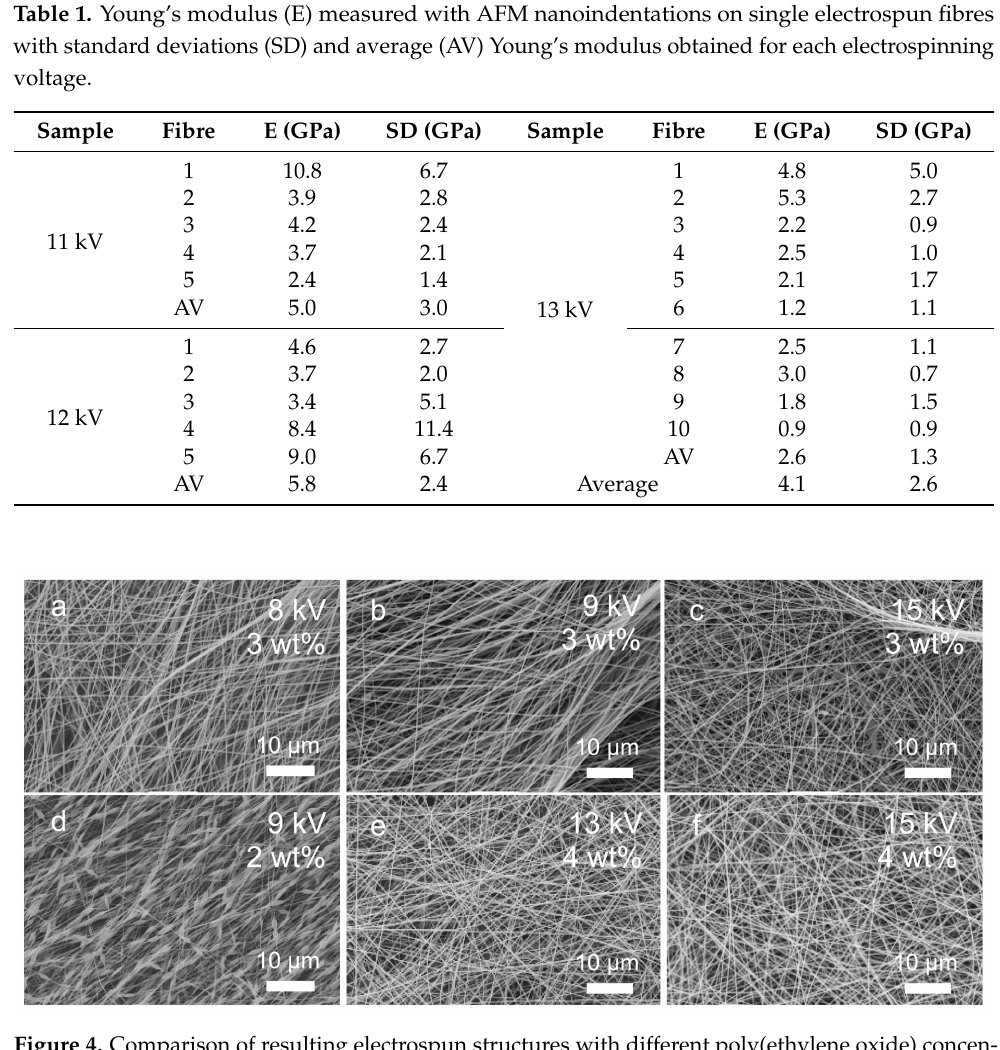
Figure 4. Comparison of resulting electrospun structures with different poly(ethylene oxide) concen- trations and different voltages. All images were obtained with magnification 2000 × . Electrospun mats obtained with ( a ) 8 kV voltage and solution concentration 3 wt%, ( b ) 9 kV voltage and 3 wt% solution concentration, ( c ) 15 kV voltage and 3 wt% solution concentration, ( d ) 9 kV voltage and 2 wt% solution concentration, ( e ) 13 kV and 4 wt% solution concentration, ( f ) 15 kV voltage and 4 wt% solution